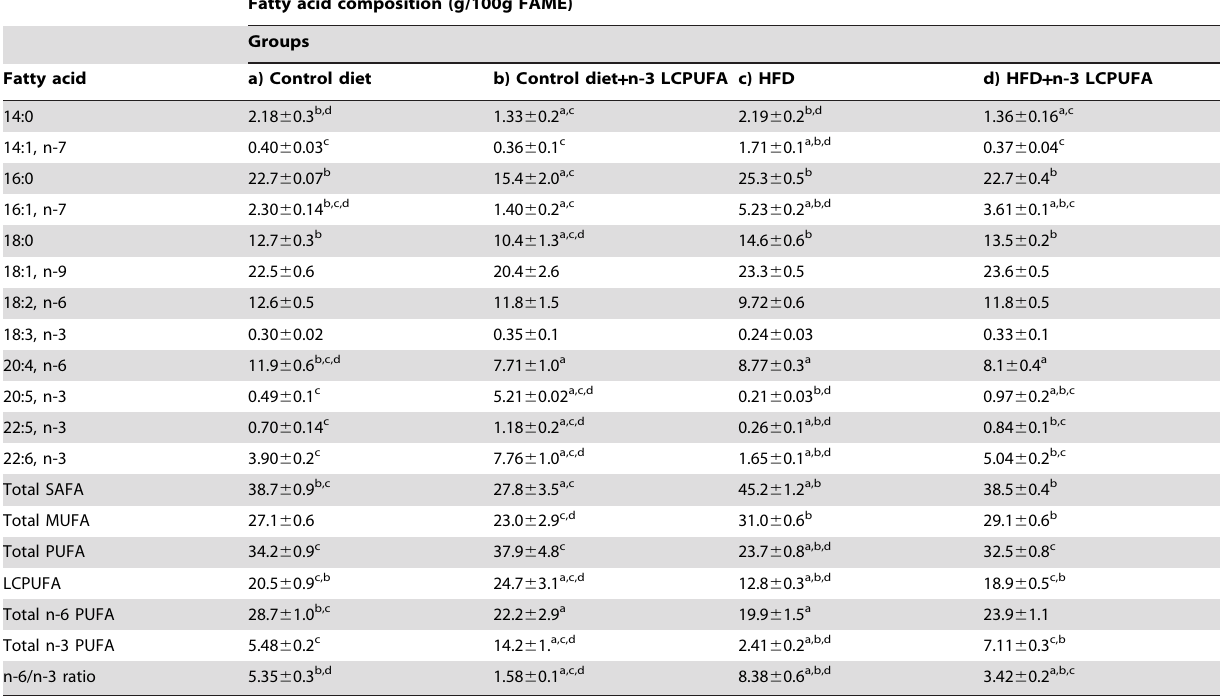
Table 2. Fatty acid composition of liver total